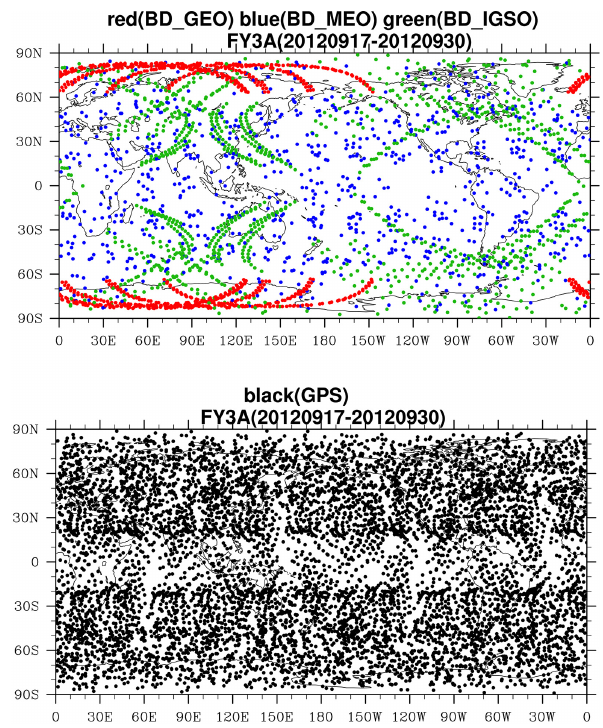
Figure 10. Beidou (top) and GPS (bottom) occultation events sim- ulation based on FY-3A satellite orbit parameters. Red dots denote the RO of the Beidou geostationary satellites, blue dots denote the RO of the Beidou middle-orbit satellites, and green dots denote the RO of the Beidou inclined geosynchronous satellites. The simula- tion period is from 17 to 30 September